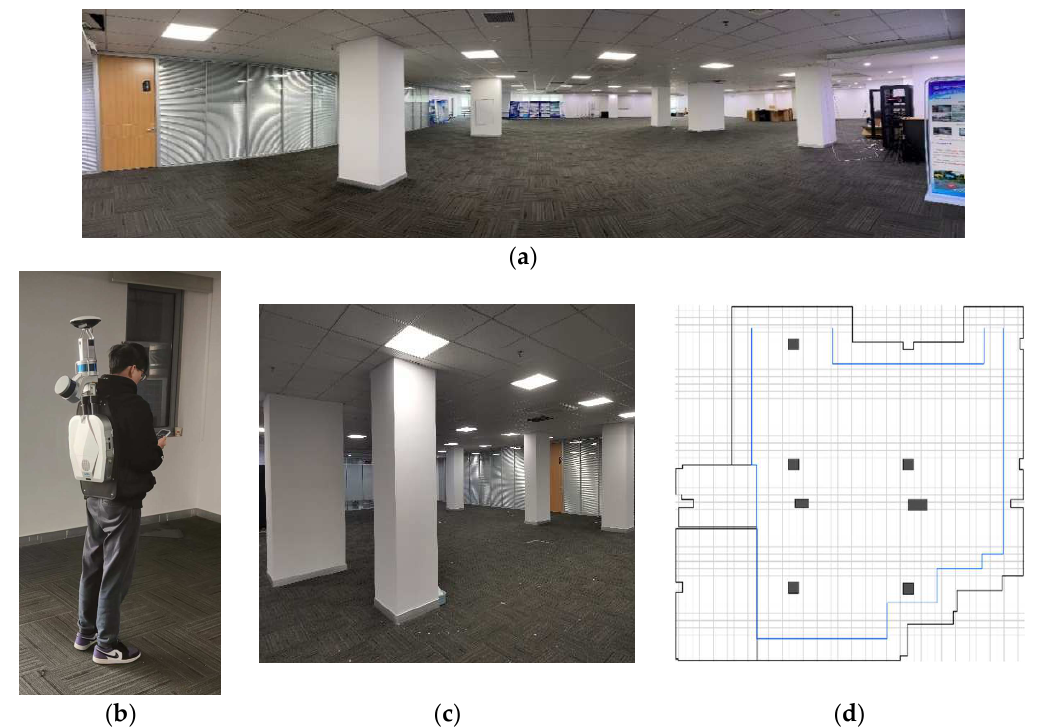
Figure 2. Experimental scene information collection and map building. ( a ) Experimental site; ( b ) LiDAR backpack; ( c ) local features of the site; and ( d ) site plan.